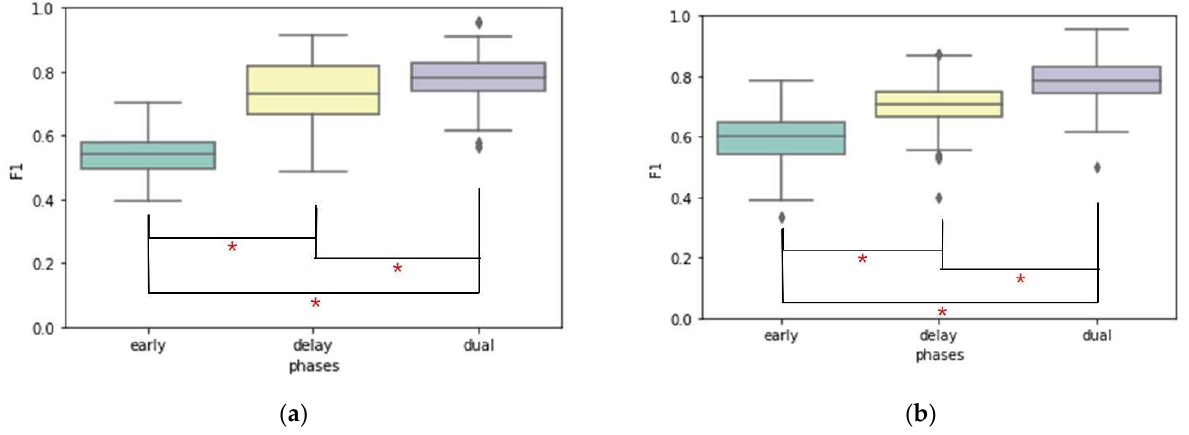
Figure 5. Boxplot of F1 score: ( a ) F1 score boxplot of composite SUVR experiment and ( b ) F1 score boxplot of regional SUVR experiment. F1: F1 score, * indicates the result of the Kruskal–Wallis test and post-hoc analysis to evaluate superiority, significant at p < 0.0001.